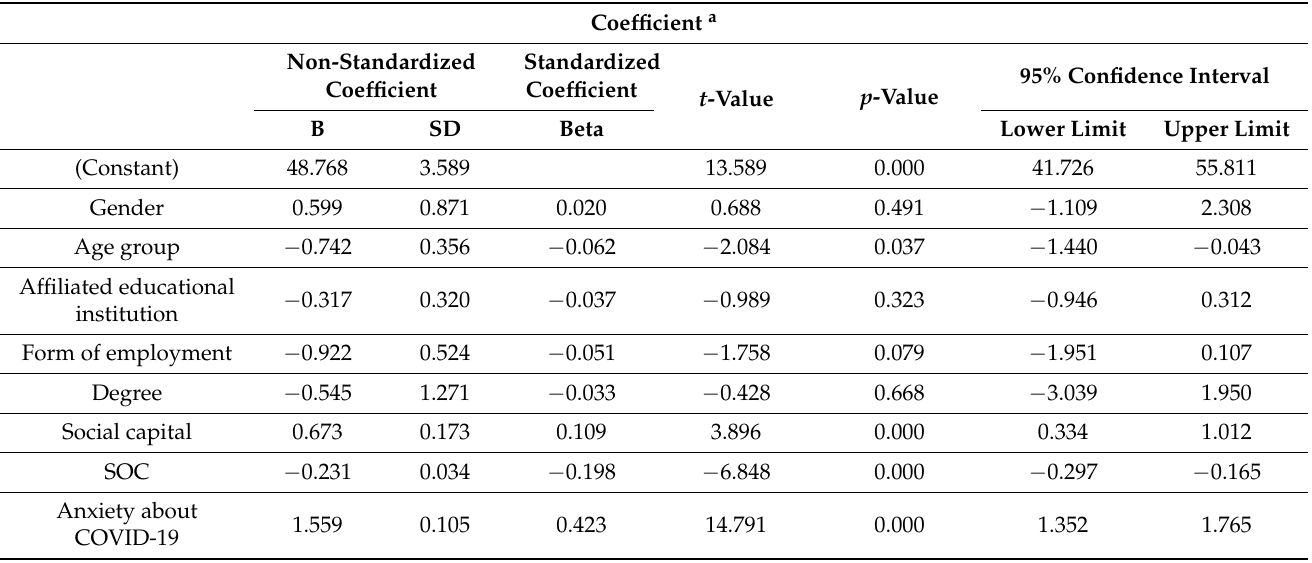
Table 6. Burden/anxiety at educational sites due to COVID-19 and influencing factors: Linear multivariate regression